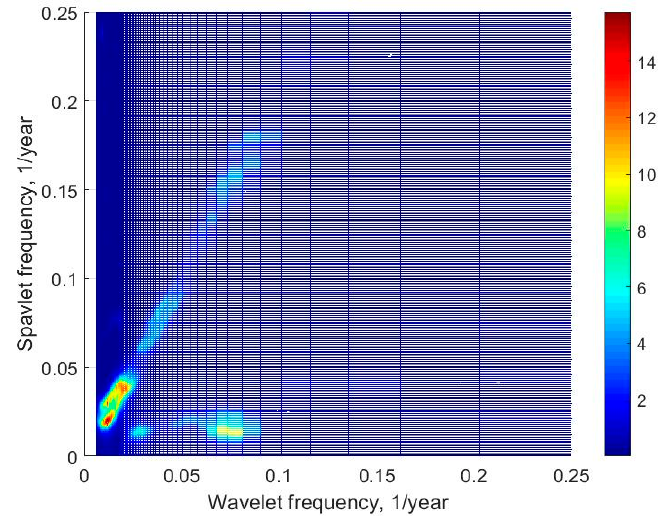
Figure 9. Spavlet of the power flux of wave energy.